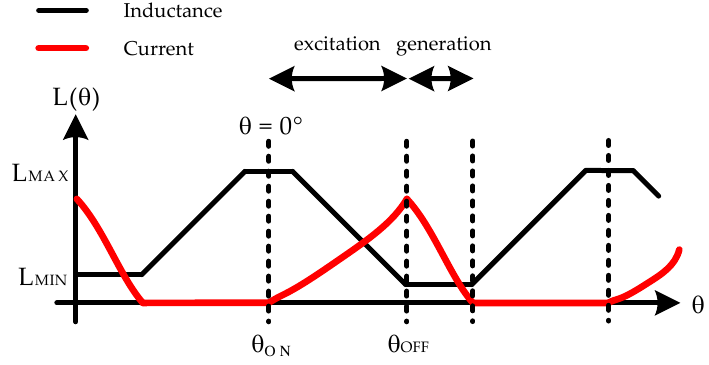
Figure 3. Inductance profile and current waveform in one of the SRG